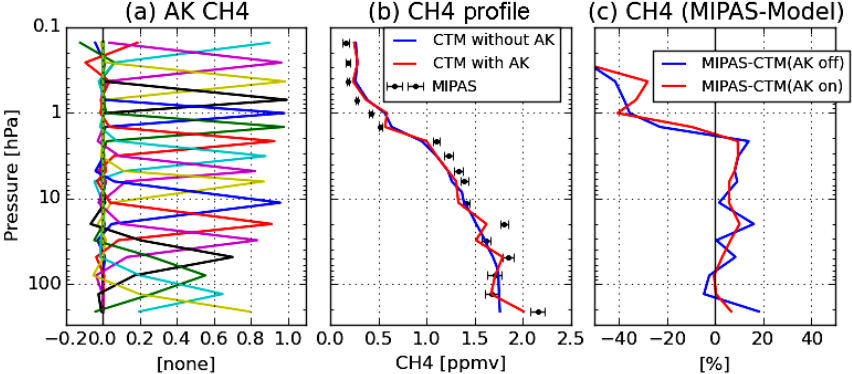
Figure 1. Examples of MIPAS AKs (a) , MIPAS and BASCOE profiles (b) and profile differences MIPAS–BASCOE (c) for CH 4 on 4 April 2008 in the equatorial region. Profiles are given for MIPAS (black circles with error bars) and for two BASCOE CTM profiles interpo- lated at the MIPAS geolocation. Blue line is BASCOE interpolated at the observation location without using the AKs while red line shows results when AKs are used. Difference between MIPAS and BASCOE is given when AKs are (red line) and are not used (blue